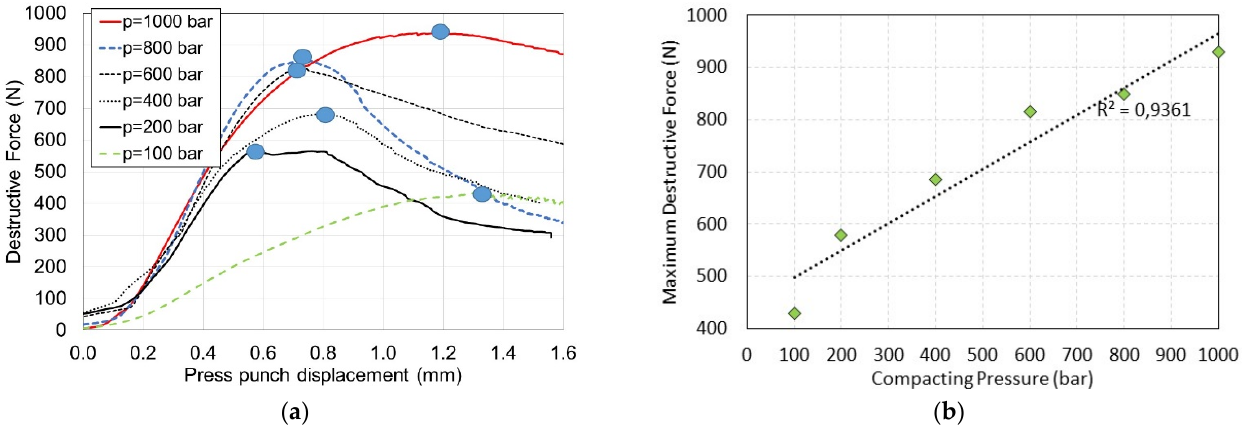
Figure 7. ( a ) The destructive force vs. press punch displacement for tests with various compaction pressures for briquettes at the temperature of 200 °C; ( b ) maximum destructive force vs. compaction pressure for briquettes.